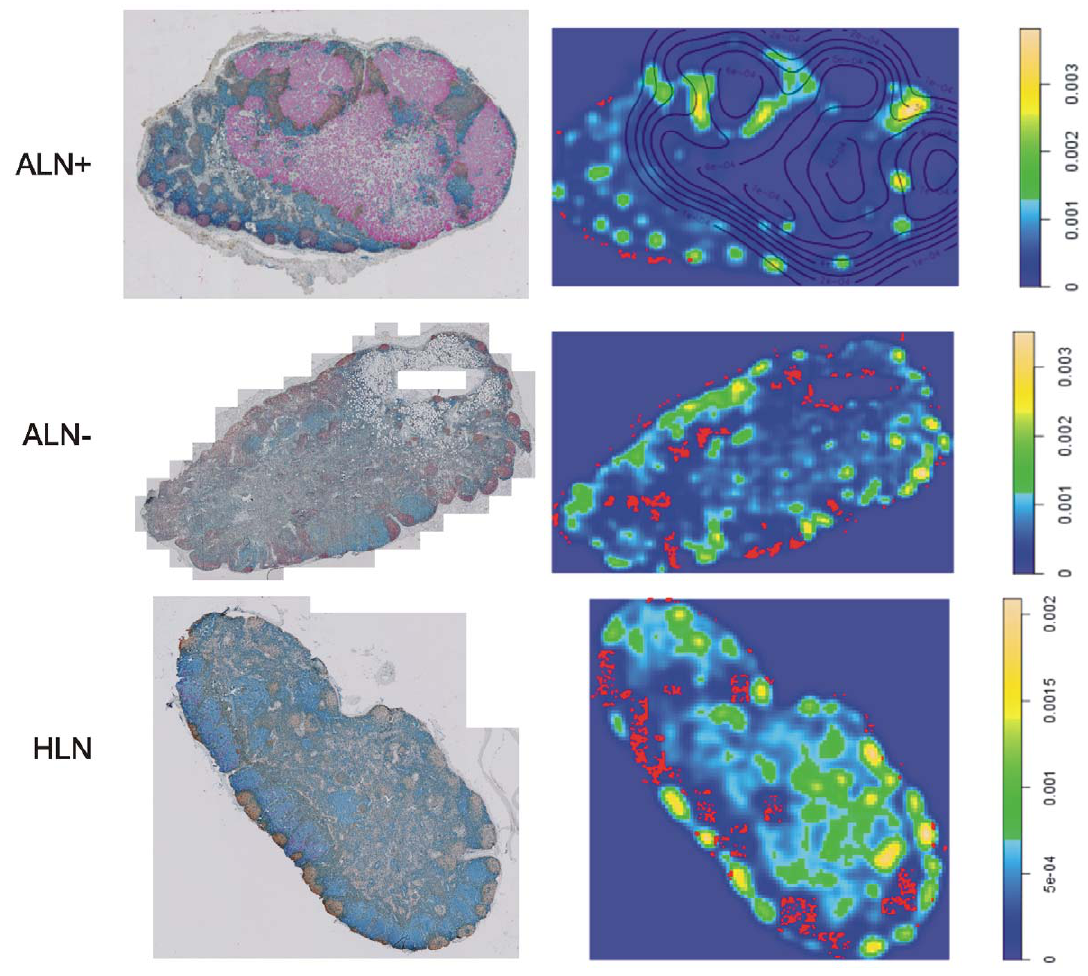
Figure 5. Representative whole-section images and density plots of B cells in an ALN + , ALN 2 and HLN. The proportion of B cell isolates is the highest in the HLNs. On whole-section images: blue: T cells; brown: B cells; red: tumor cells. On density plots: red dots: B cell isolates (lowest 15% of density); yellow and green: B cell aggregates (highest 85% of density); lines: tumor contours.